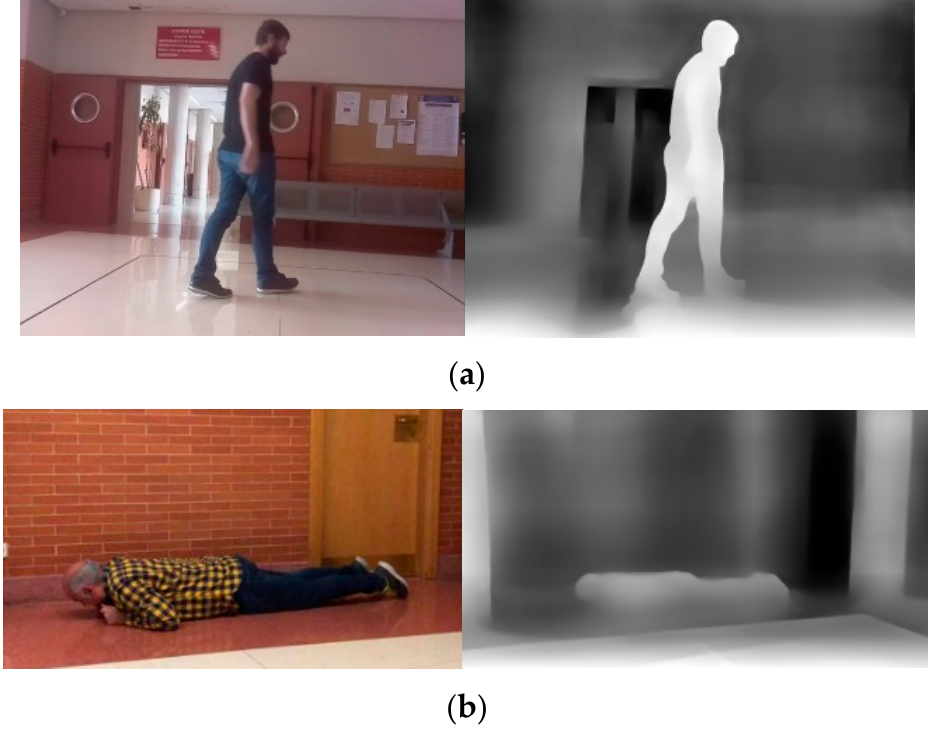
Figure 1. Comparison of RGB and depth images: ( a ) non-fallen and ( b ) fallen (left: RGB images, right: depth images). Images from the Fallen People Dataset (FPDS) [8].